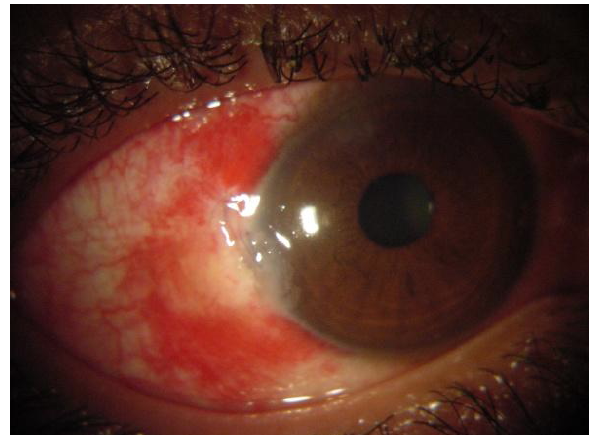
Figure 3: Anterior segment of the right eye after IOFB removal right eye was count fingers. Anterior segment Figure 1: A nail has lodged in the right eye The patient was diagnosed with an IOFB in the right eye.